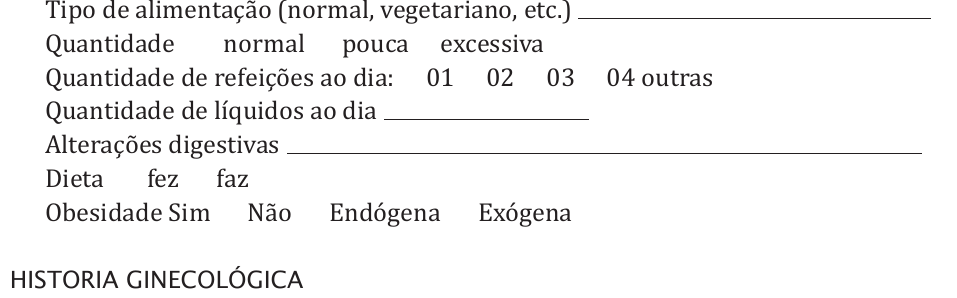
Idade da 1ª menstruação